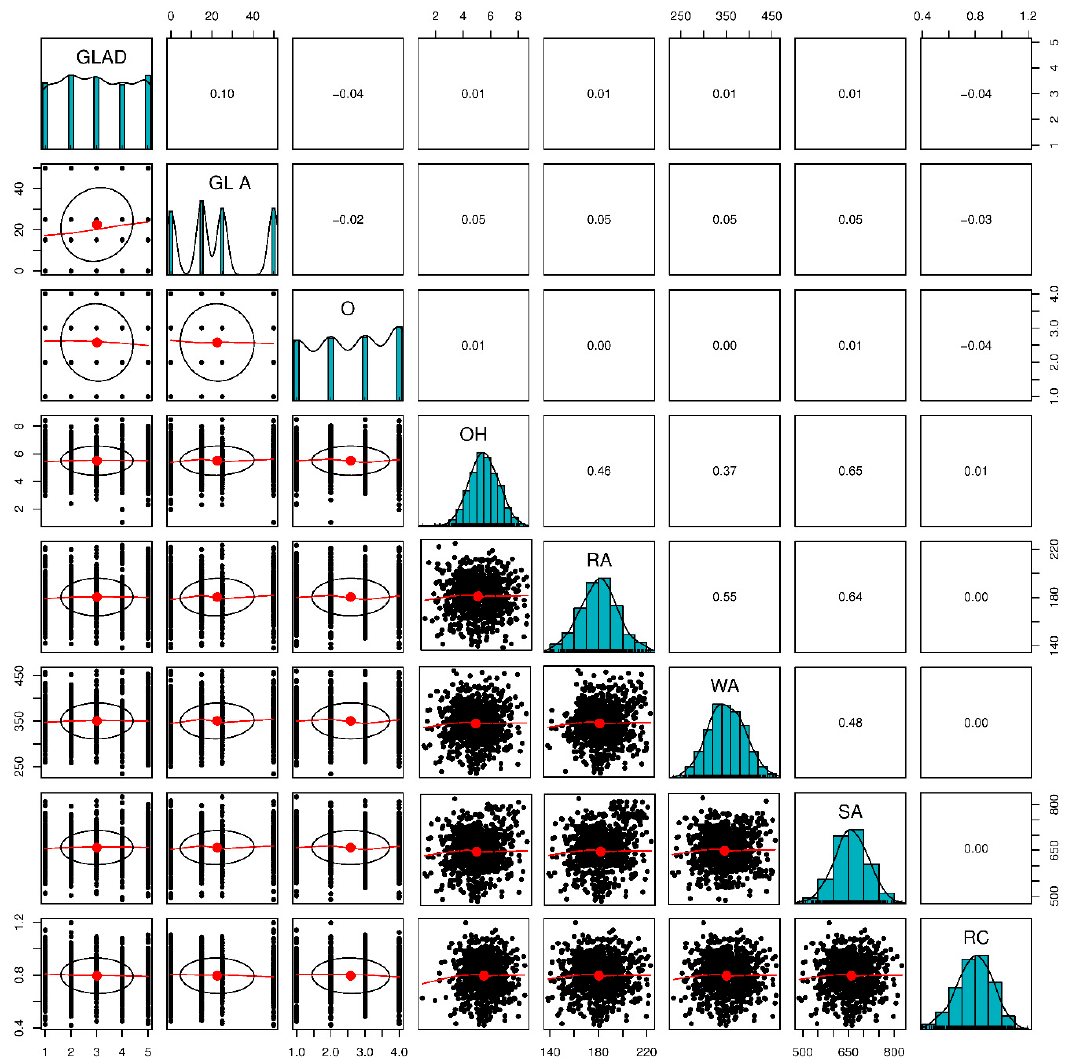
Figure 2. Properties of the dataset used for estimating heating load (HL) of buildings’ energy efficiency (EEB) systems.